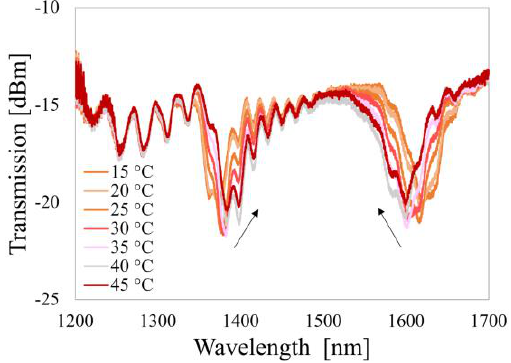
Figure 10. Spectral responses of the Al 2 O 3 -LPG-µIMZI structure in water to variations of T.